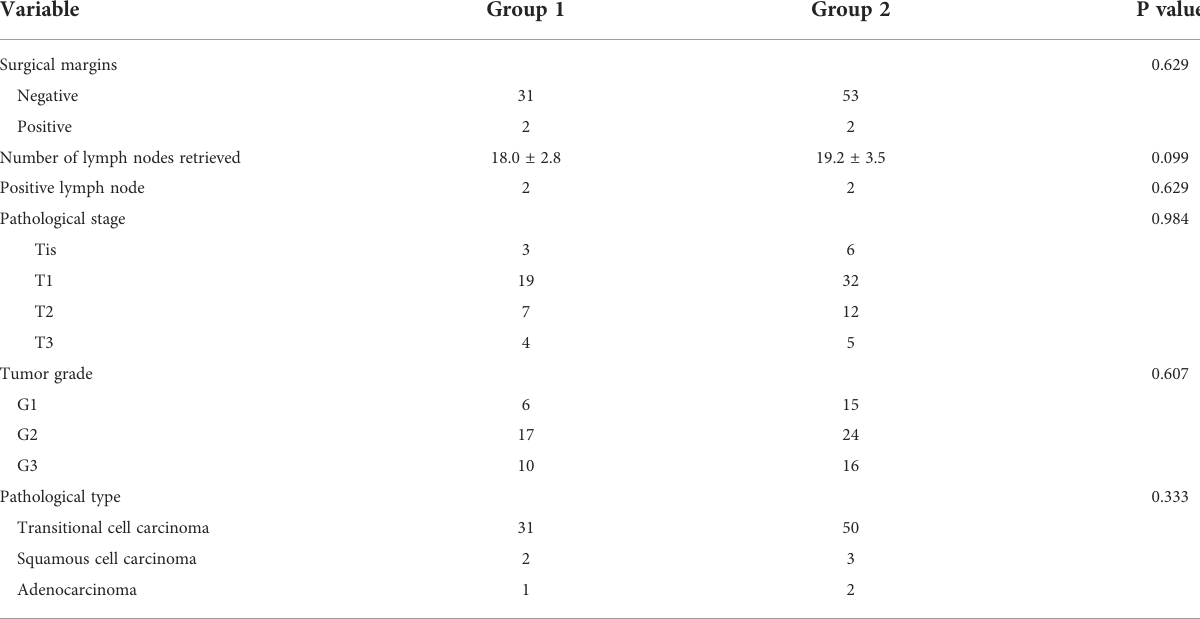
TABLE 2 Postoperative pathological results of bladder cancer patients in two groups.